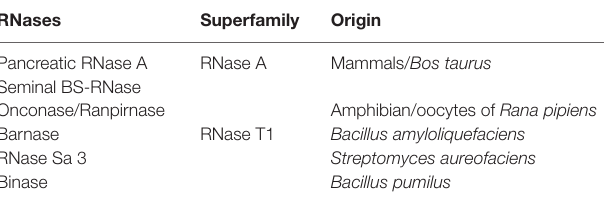
TABLE 2 | Exogenous RNases of different origin displaying antitumor activity.